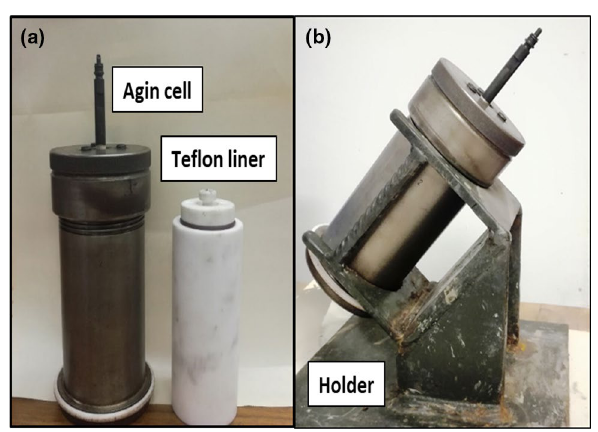
Fig. 1 Apparatus for static sag test: a vertical and b inclined (45°) (Elkatatny 2019)